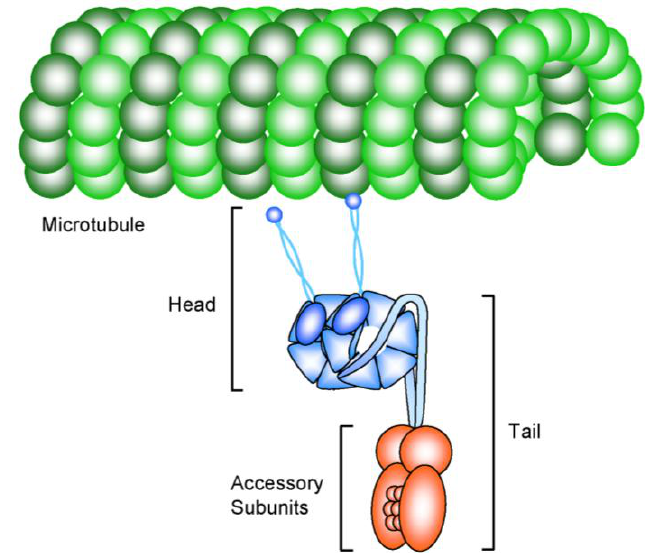
FIGURE 1. The cytoplasmic dynein complex. The catalytic head is responsible for microtubule binding and force production. Dynein advances along the microtubule by shuffling its heads in a hand-over-hand manner. Accessory subunits at the base of the tail domain mediate binding of intracellular cargo.